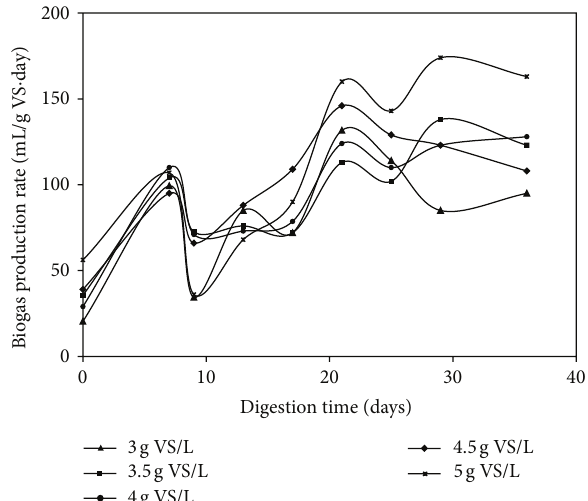
Figure 6: Biogas production rate mL/gVS for grass.